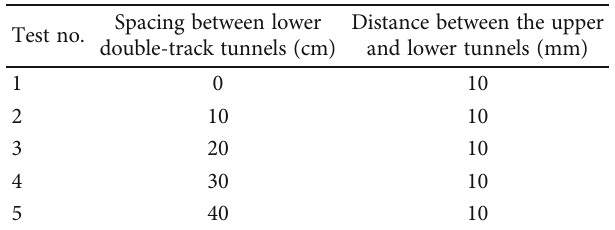
Figure 9: Speckle diagram of upper tunnel. Table 4: Test